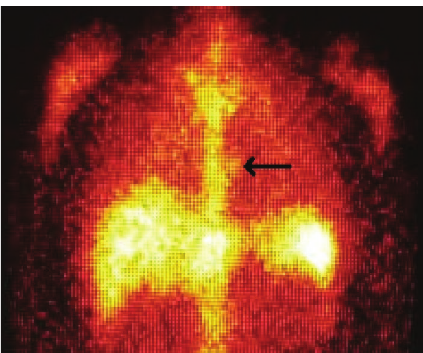
Figure 1: Indium-111 tagged WBC scintigraphy with focal area of asymmetric radiotracer uptake in the area of the mitral valve (arrow), coronal